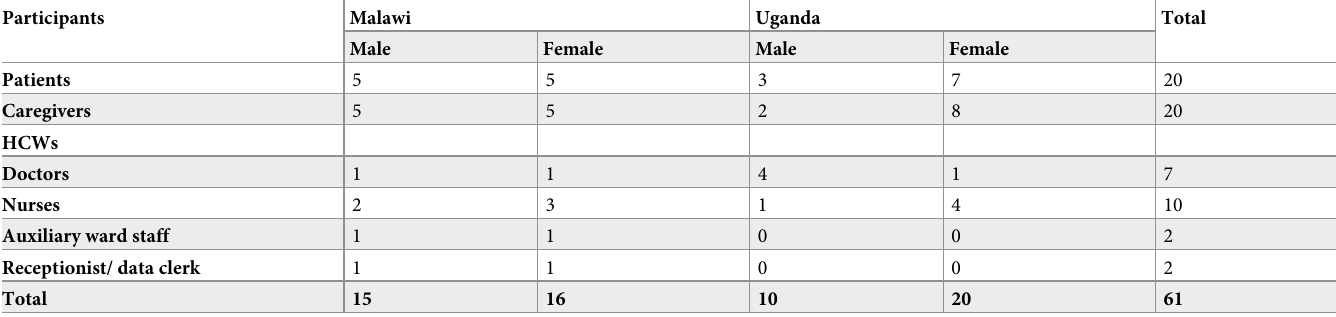
Table 1. Characteristics of study